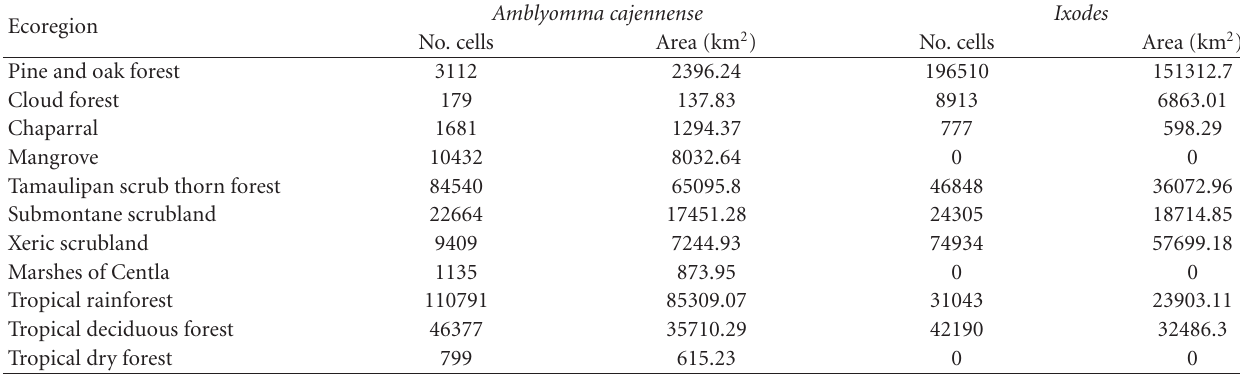
Table 5: Ecoregion occupancy by Amblyomma cajennense and the Ixodes group.